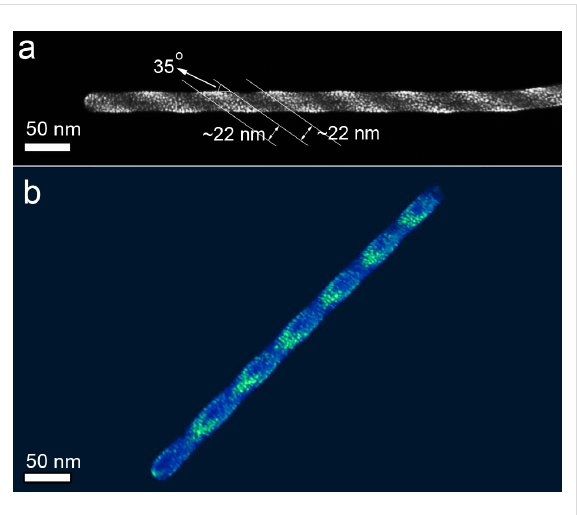
Figure 5: (a) HAADF-STEM image of a CNT with stripe-pattern of Pt nanoclusters from FEBID. (b) A snapshot from the 3D reconstruction of the